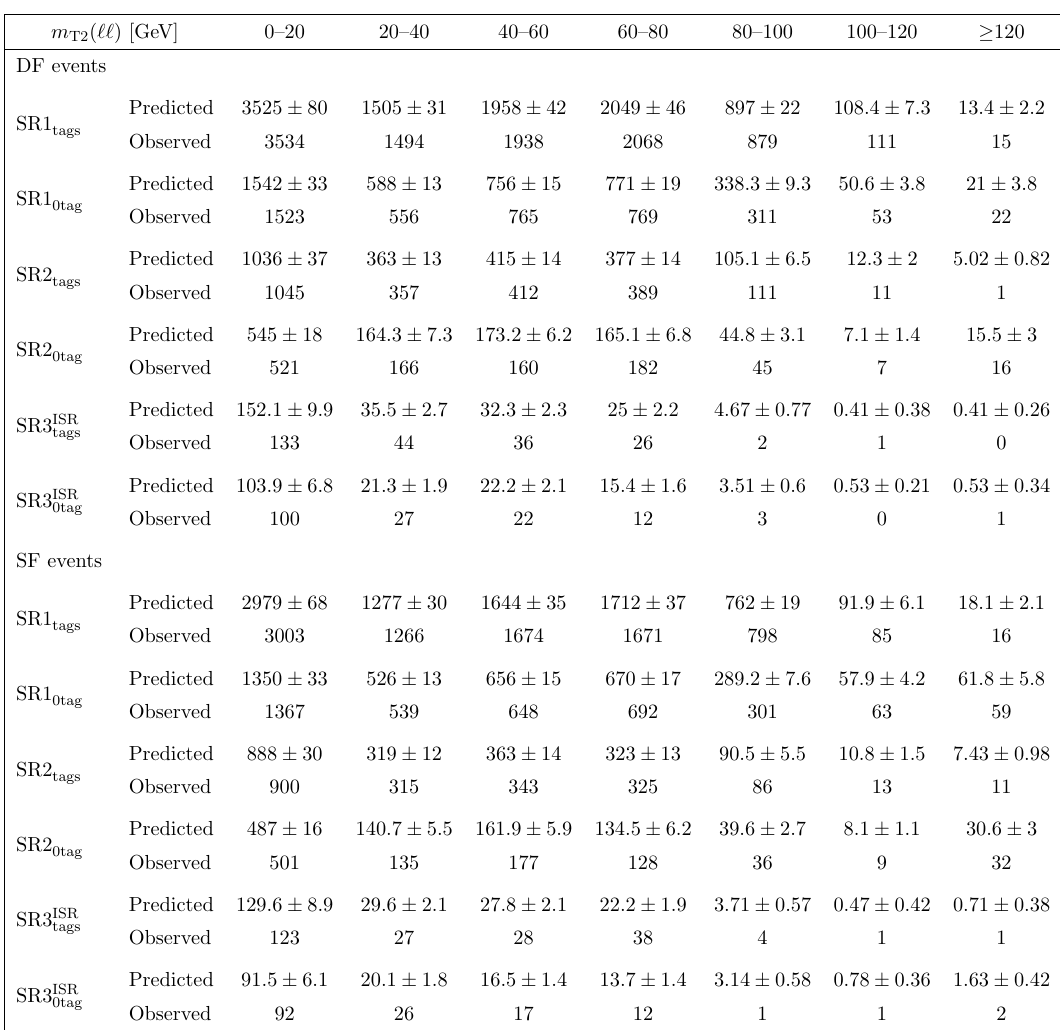
Table 8 . Observed and expected yields of DF (the upper half of table) and SF (the lower half) events in the SRs for the top squark search. The quoted uncertainties in the background predictions include statistical and systematic